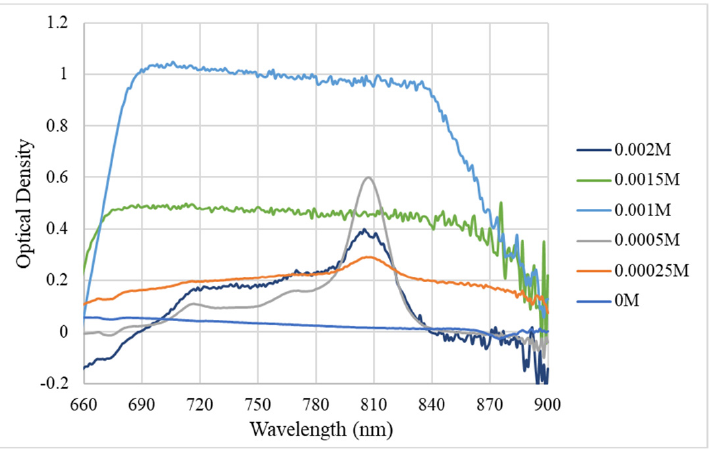
Figure 1. Absorbency spectra of EVA solution with different dyestuff concentrations.